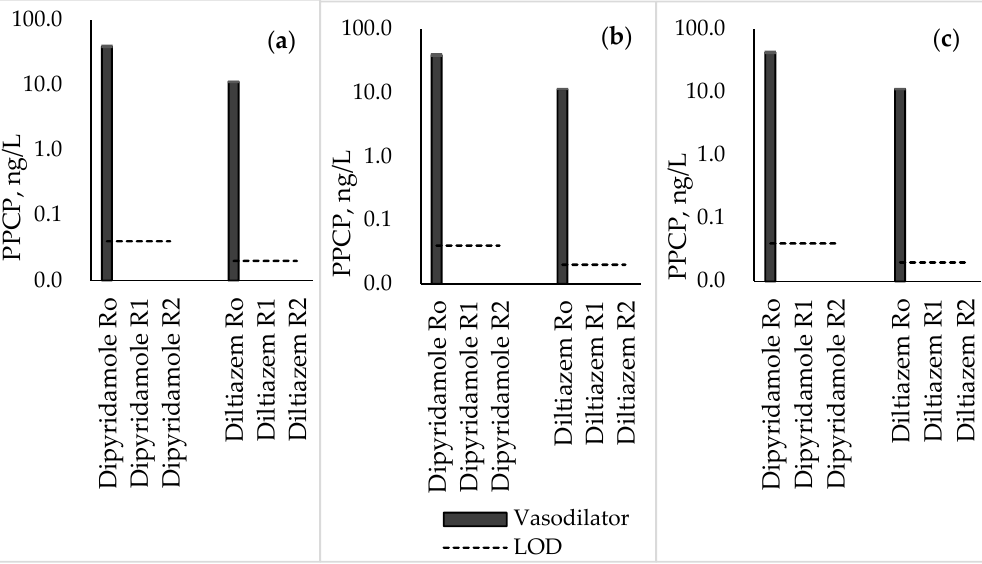
Figure 6. Concentrations of two vasodilators in the feed secondary effluent (R o ) and effluent of the R 1 and R 2 reactors at the O 3 doses of: ( a ) 1 and 2 mg L − 1 , respectively, in Run 1; ( b ) 2 and 4 mg L − 1 , respectively, in Run 2; and ( c ) 3 and 6 mg L − 1 , respectively, in Run 3.